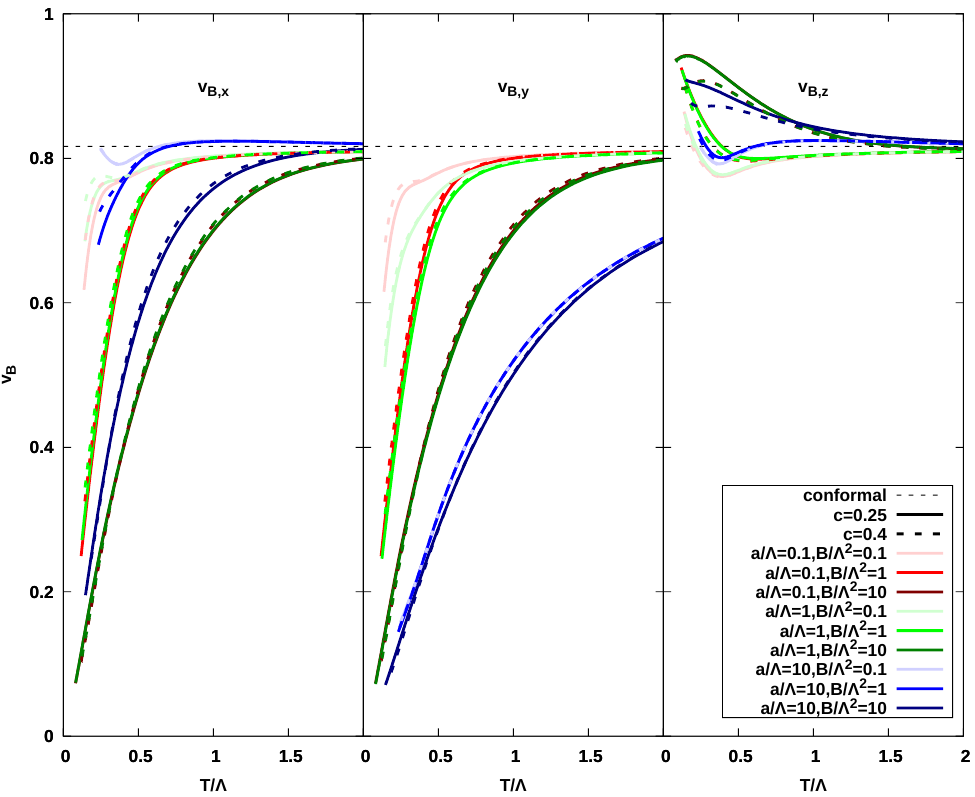
Figure 13 . Components of the butterfly velocity as a function of temperature (in units of Λ ∼ 1 GeV) for the perpendicular configuration. The magnetic field B is aligned along the z -direction while the anisotropic deformation is introduced along the y -direction. The solid lines depict results for c = 0 . 25 , which we have kept for comparison, while dashed lines show the corresponding results for c = 0 . 4 . In both cases we observe that the component v z is enhanced in the IR and exceeds B the bound found in [27], although its maximum value decreases with the increase of c . On the other hand, the other components v x and v y show a slight increase with respect to the results B B for c = 0 . 25